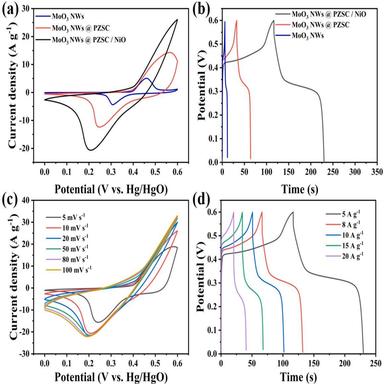
(a) CV curves scan at 10 mV s−1 of MoO3, MoO3 @ PZSC and MoO3 @ PZSC/NiO. (b) GCD curves at 5 A g−1 of MoO3, MoO3 @ PZSC and MoO3 @ PZSC/NiO. (c) CV curves scan at various rates of MoO3 @ PZSC/NiO. (d) GCD curves of MoO3 @ PZSC/NiO with various current densities.